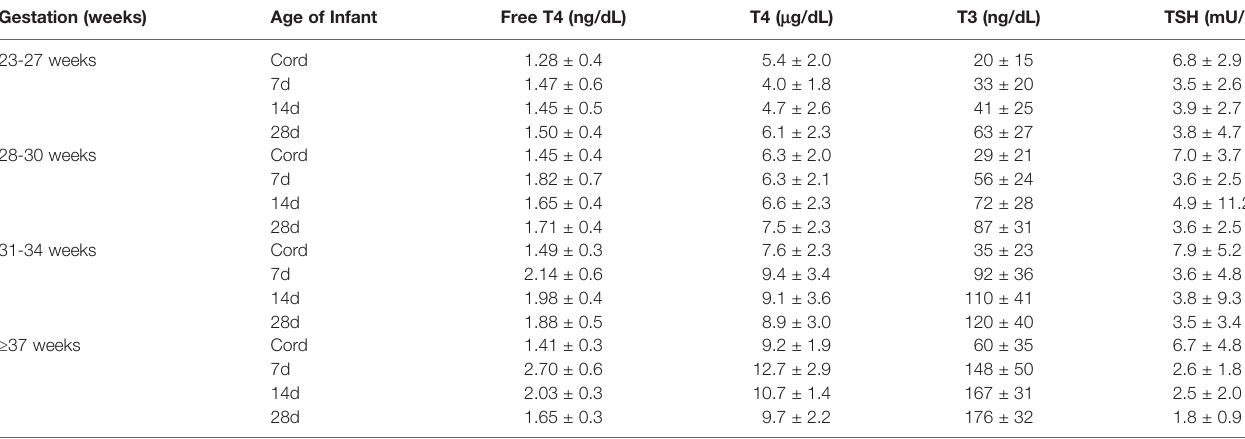
TABLE 1 | Concentrations of free T4, T4, T3, and TSH in preterm and term infants in cord blood at birth, and at 7, 14, and 28 days of age (mean +/- 1 SD). Gestation